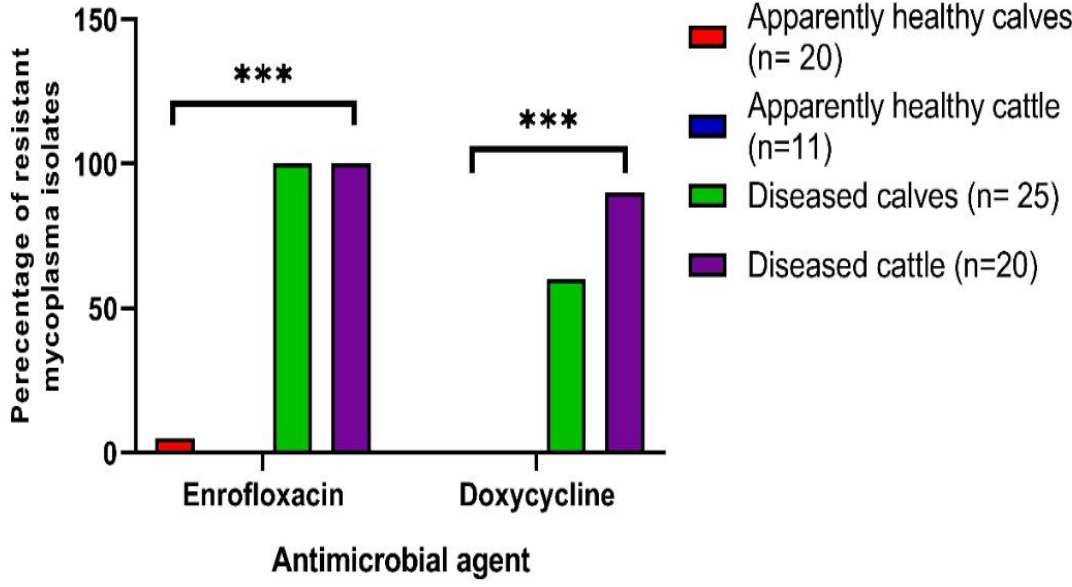
Figure 2. Prevalence rates of enrofloxacin and doxycycline among mycoplasma isolates from differ- ent samples ʼ sources. Ns: nasal swabs, Ts: tracheal swabs, Lt: lung tissue, Tt: tracheal tissue, *** p < 0.001.